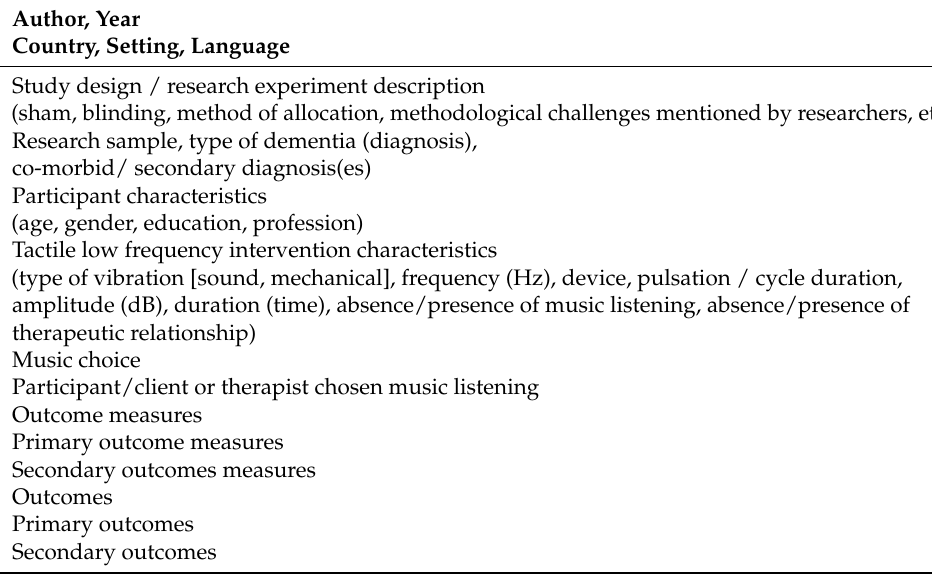
Table 1. Data extraction tool developed by the